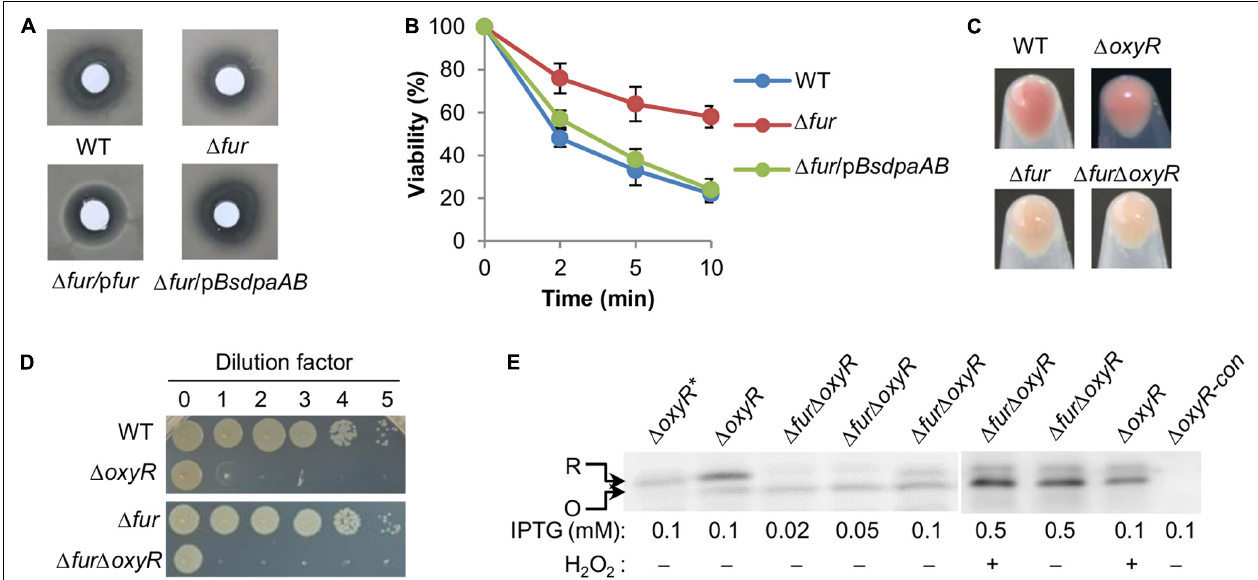
FIGURE 5 | The Fur loss activates OxyR. (A,B) Effects of the fur mutation on sensitivity of S. oneidensis to H 2 O 2 . p BsdpaAB , B. subtilis dpaAB gene under the control of P tac within pHGE-Ptac. Disk diffusion assay (A) : paper disks of 6 mm in diameter loaded with 10 µ l of 5 M H 2 O 2 were placed on bacterial lawns (pre-grown for 6 h). Results shown were 24 h after the disks were in place. Survival assay (B) : H 2 O 2 was added to the mid-exponential phase cultures adjusted to 0.4 of OD 600 to a final concentration of 5 mM and viable cells were counted by plating. (C,D) Physiological functions of OxyR and Fur appear non-overlapping as shown by the cell pellet color (C) and viability on LB plates (D) . (E) Immunoblot analysis of OxyR. In the indicated strains, His 6 -tagged protein expression was induced with IPTG. Mid-exponential phase cells either treated with H 2 O 2 of indicated concentrations for 30 min or not were collected, processed, and analyzed with antibodies against the hexahistidine tag. R, reduced form; O, oxidized form. Experiments were performed at least three times, and representative results are shown. *Represents OxyR C203S , a mutant that could not be activated. (cid:49) oxyR -con, the (cid:49) oxyR strain does not express a his6-tagged OxyR as the